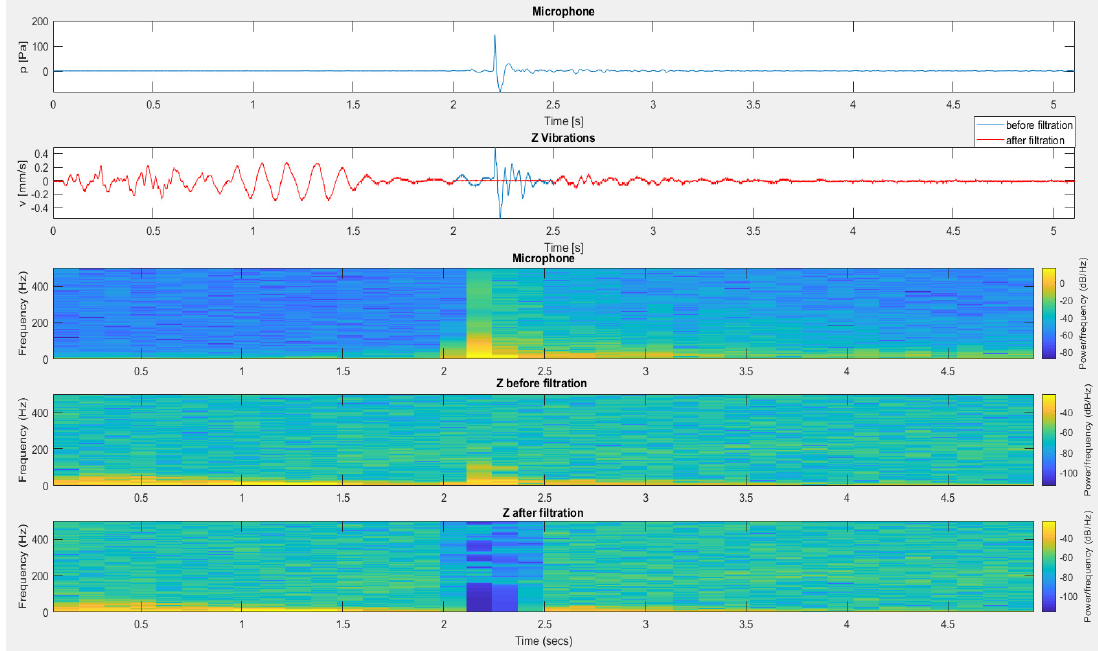
Figure 22. The result of using filtration for the vertical component—firing a series of long-hole blasts.